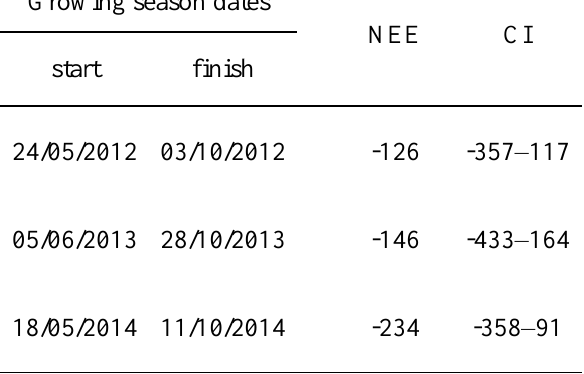
Table 4. Modelled growing season net ecosystem exchange (NEE; carbon equivalents) and 95 % confidence intervals (CI). Units: g m -2